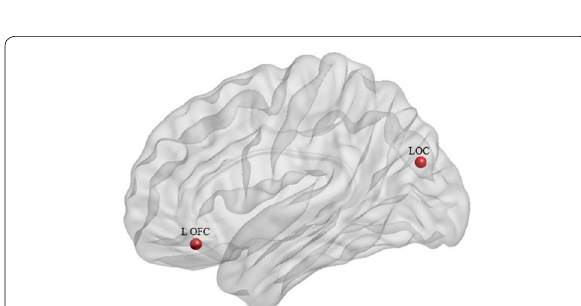
Fig. 3 The location of two ROIs in the brain which progressively decreased with the deterioration of disease. L OFC: left orbitofrontal cortex, LOC: lateral occipital cortex